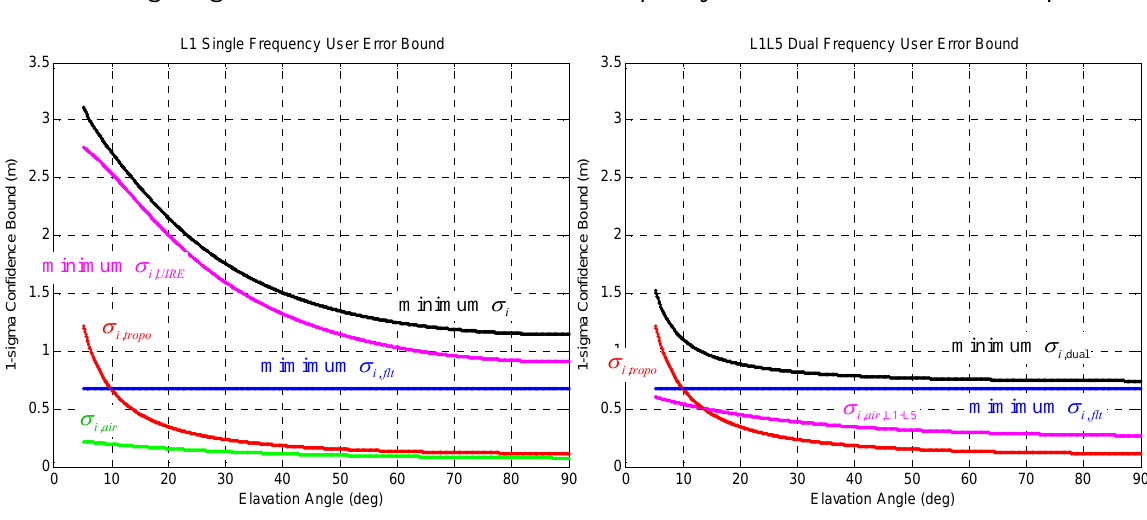
Figure 6. The minimum user error components as a function of satellite elevation angle. The left figure is the minimum L1 single frequency GPS/WAAS user error components, and the right figure is the minimum L1-L5 dual-frequency GPS/WAAS user error components.